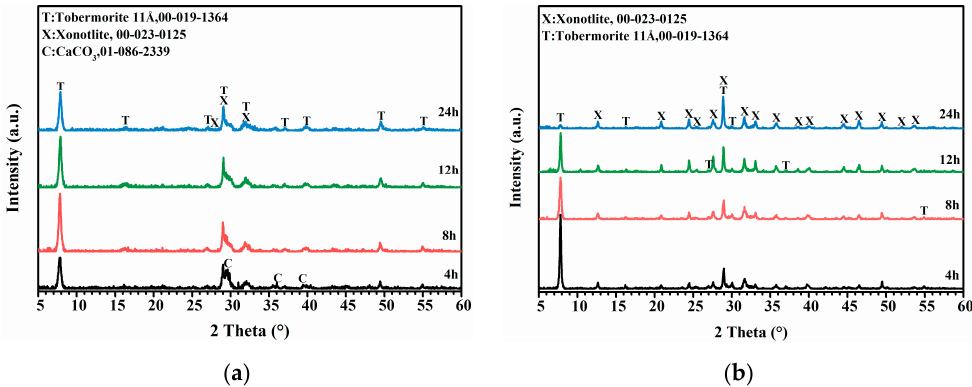
Figure 6. XRD patterns of samples synthesized at 220 °C hydrated cement M0 ( a ) and calcined hydrated cement M900 ( b ).